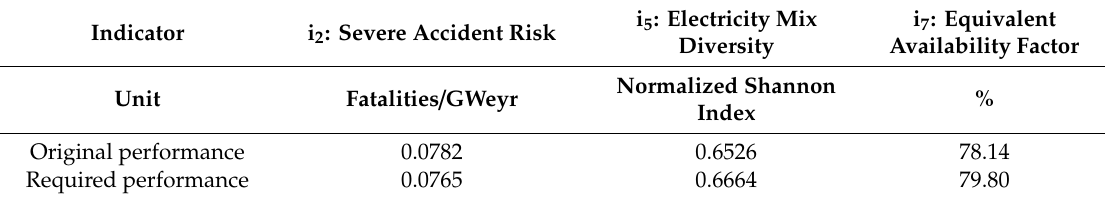
Table 14. Required minimum performance on i2, i5 and i7 in order to make Japan e ffi